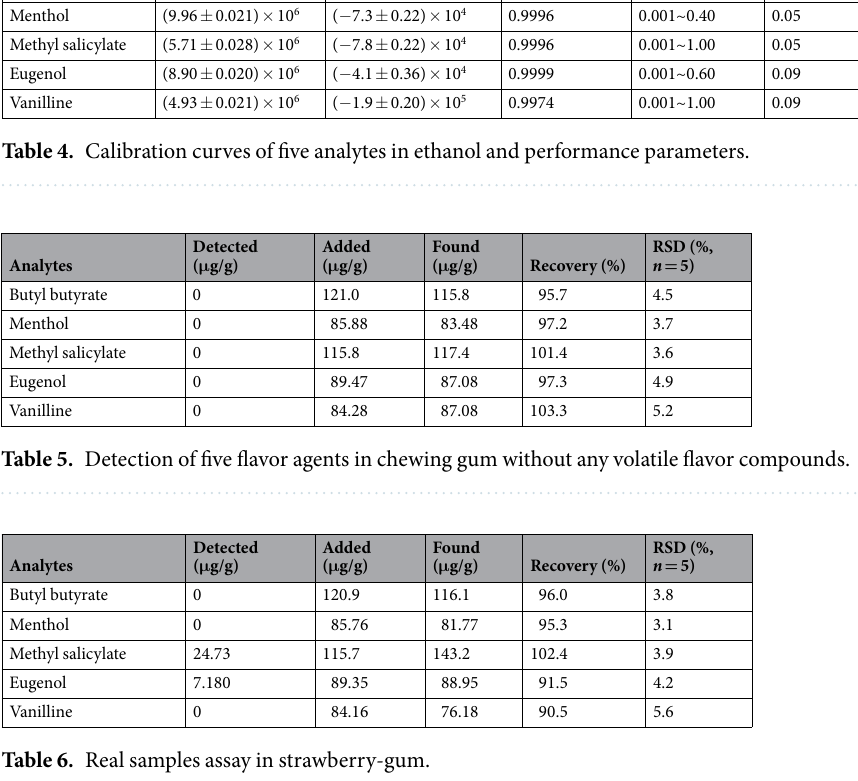
Table 6. Real samples assay in